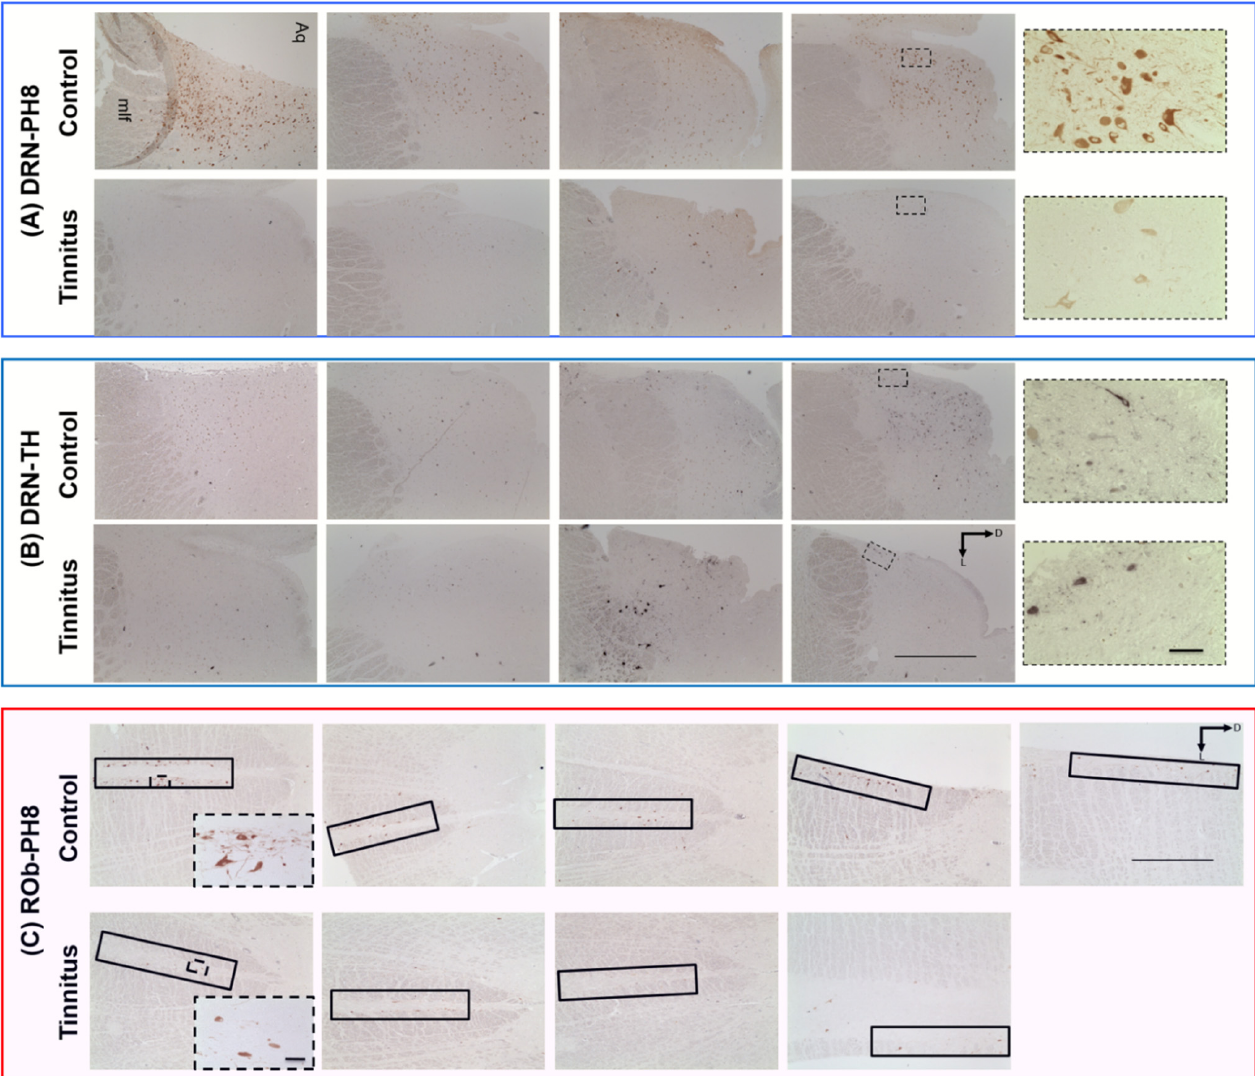
Figure 5. Representative low-power photomicrographs showing the brain sections containing the DRN (in blue rectangles) stained with PH8 ( A ) and adjacent sections stained with TH ( B ). A high- power photomicrograph of one subject (higher magnification of the dotted square) is shown in the right box in each line. Photomicrographs showing the ROb stained with PH8 (in red rectangle, ( C )). Scale bar = 1 mm and for insets = 50 µm. Aq, cerebral aqueduct; D, dorsal; L, lateral; mlf, medial longitudinal fasciculus; Rob, obscurus raphe nuclei; TH, tyrosine hydroxylase; PH8, phenylalanine hydroxylase 8.